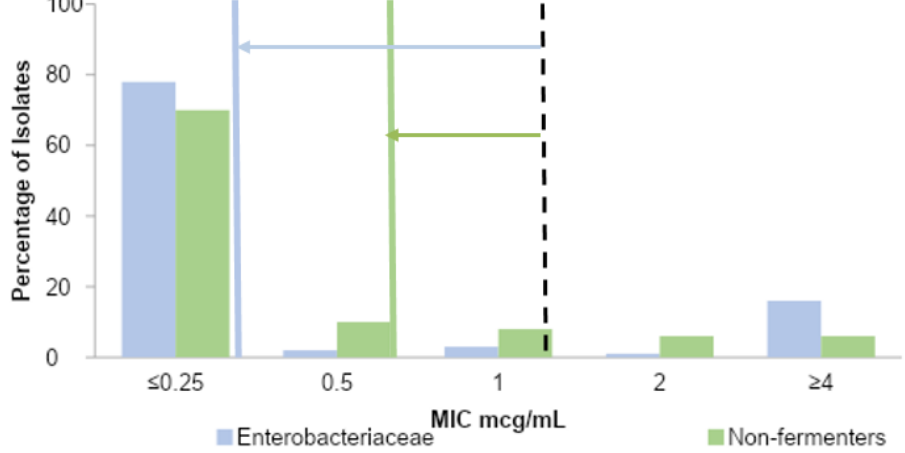
Figure 2. Ciprofloxacin minimum inhibitory concentration (MIC) values for Enterobacteriaceae and non-fermenters. Dashed line represents previous ciprofloxacin MIC breakpoints for Enterobacteriaceae and non-fermenters, and the solid lines represent updated ciprofloxacin MIC breakpoints for Enterobacteriaceae (in blue) and non-fermenters (in green). The arrows reflect the magnitude of the MIC shift for Enterobacteriaceae (in blue) and non-fermenters (in green). Table 1. Mean difference in ciprofloxacin susceptibilities by previous and updated breakpoints. Organism N